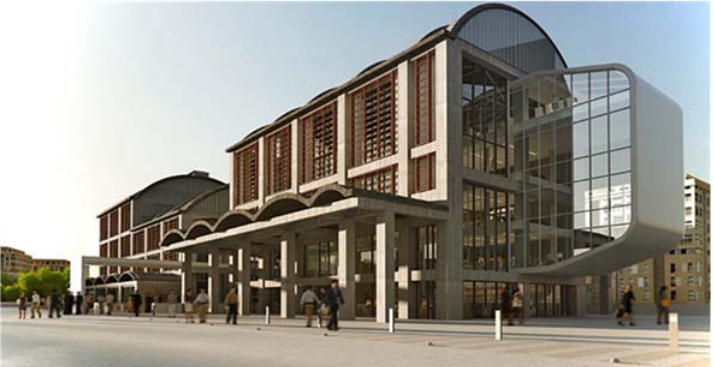
Figure 3. Final condition of the building (rendering courtesy of Diaz & Diaz Architects S.L.).